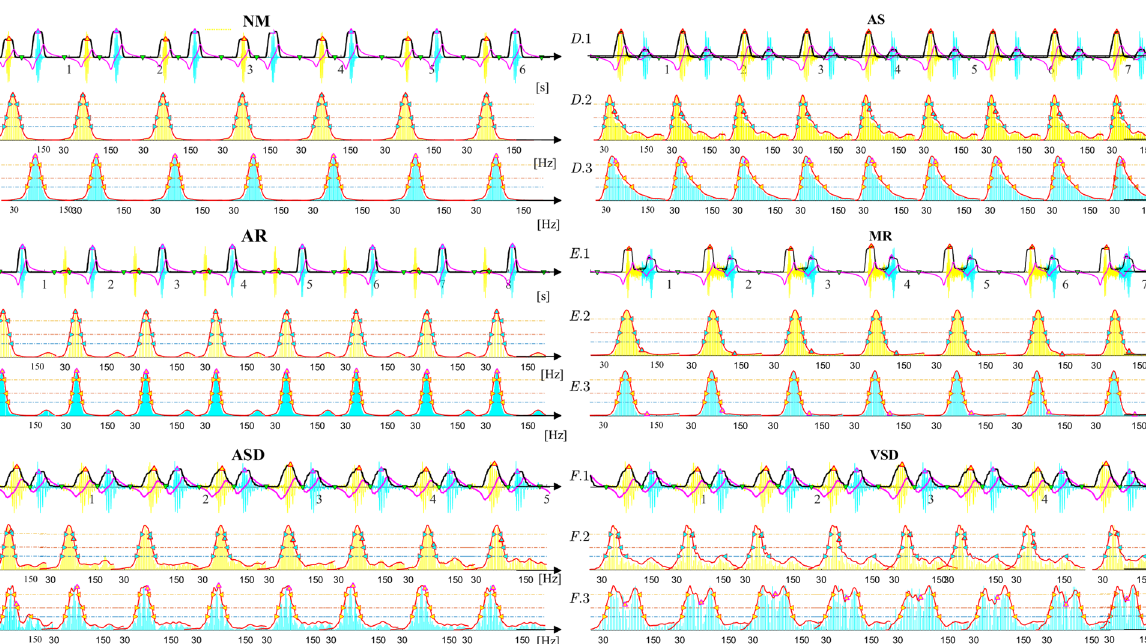
Figure 5. Examples of a typical normal sound and six types of typical heart disease